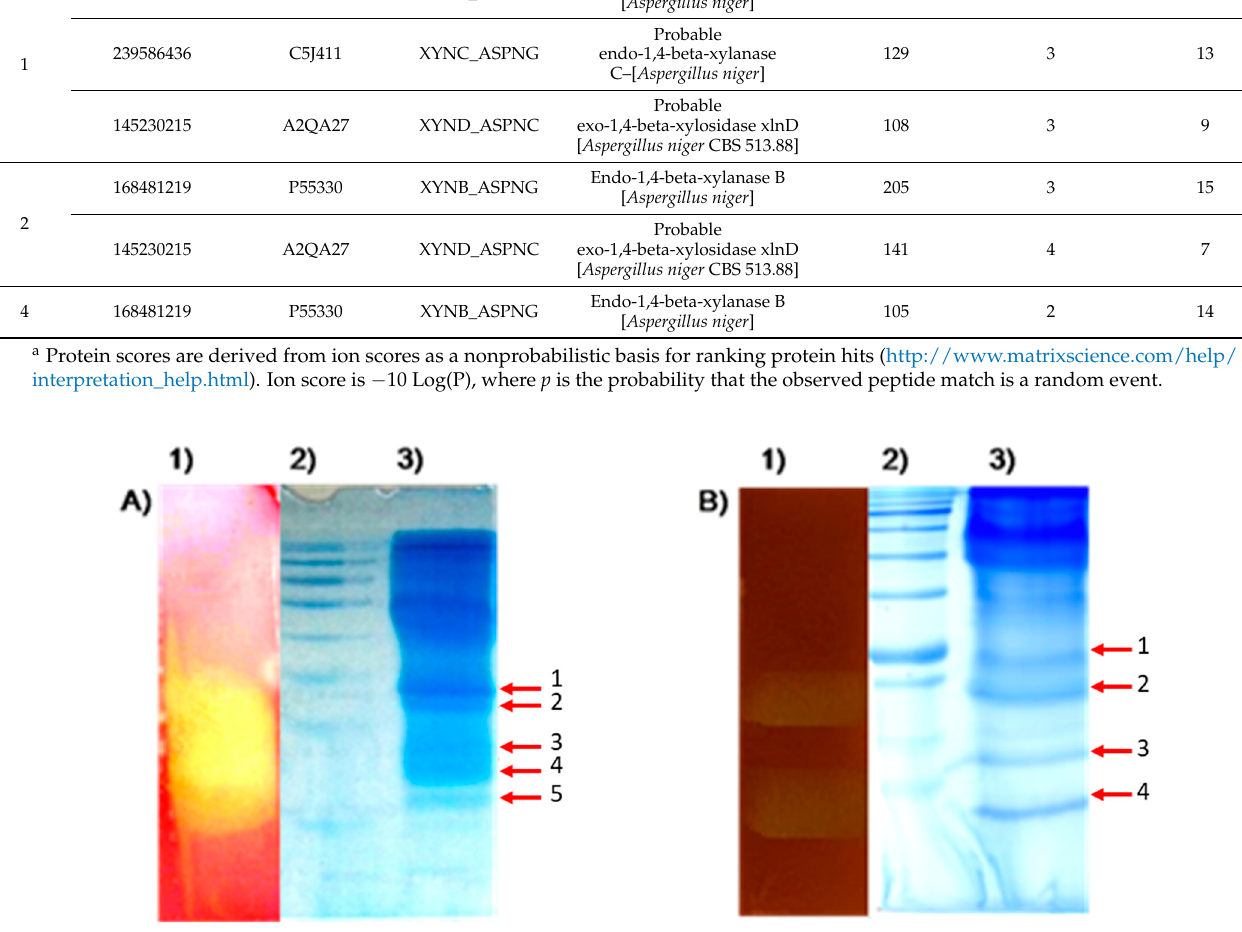
Energies 2021 , 14 , x FOR PEER REVIEW